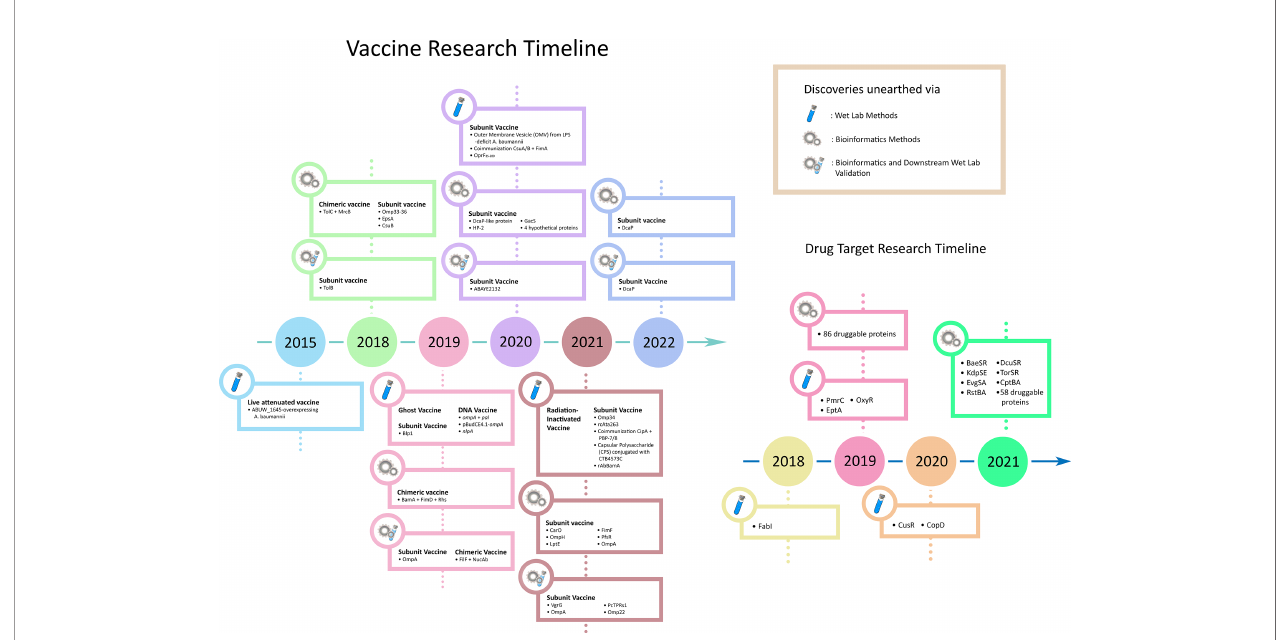
FIGURE 1 | Timeline of the development of vaccines and drug target research of A. baumannii